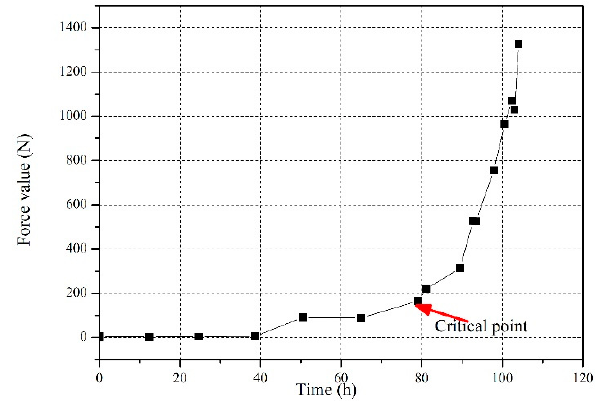
Figure 8. Test process for a specimen with a voids content of 3.4%.